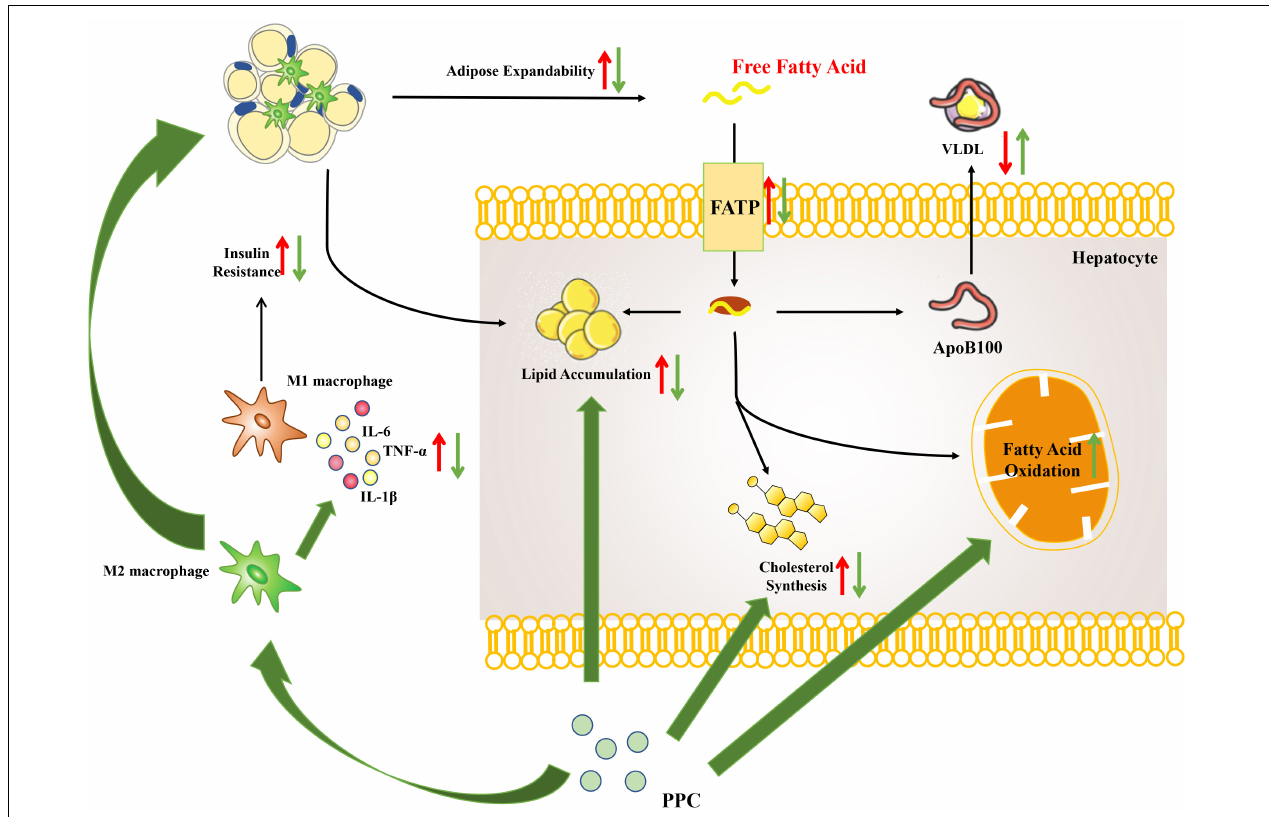
FIGURE 9 | The overview of hepatic metabolic and inflammatory reprogramming in HFD mice after PPC intervention. HFD resulted in abnormal lipid accumulation and activated pro-inflammatory macrophage (red arrows), while PPC prevented the pathology of NAFLD via remodeling metabolism and inflammation (green arrows).